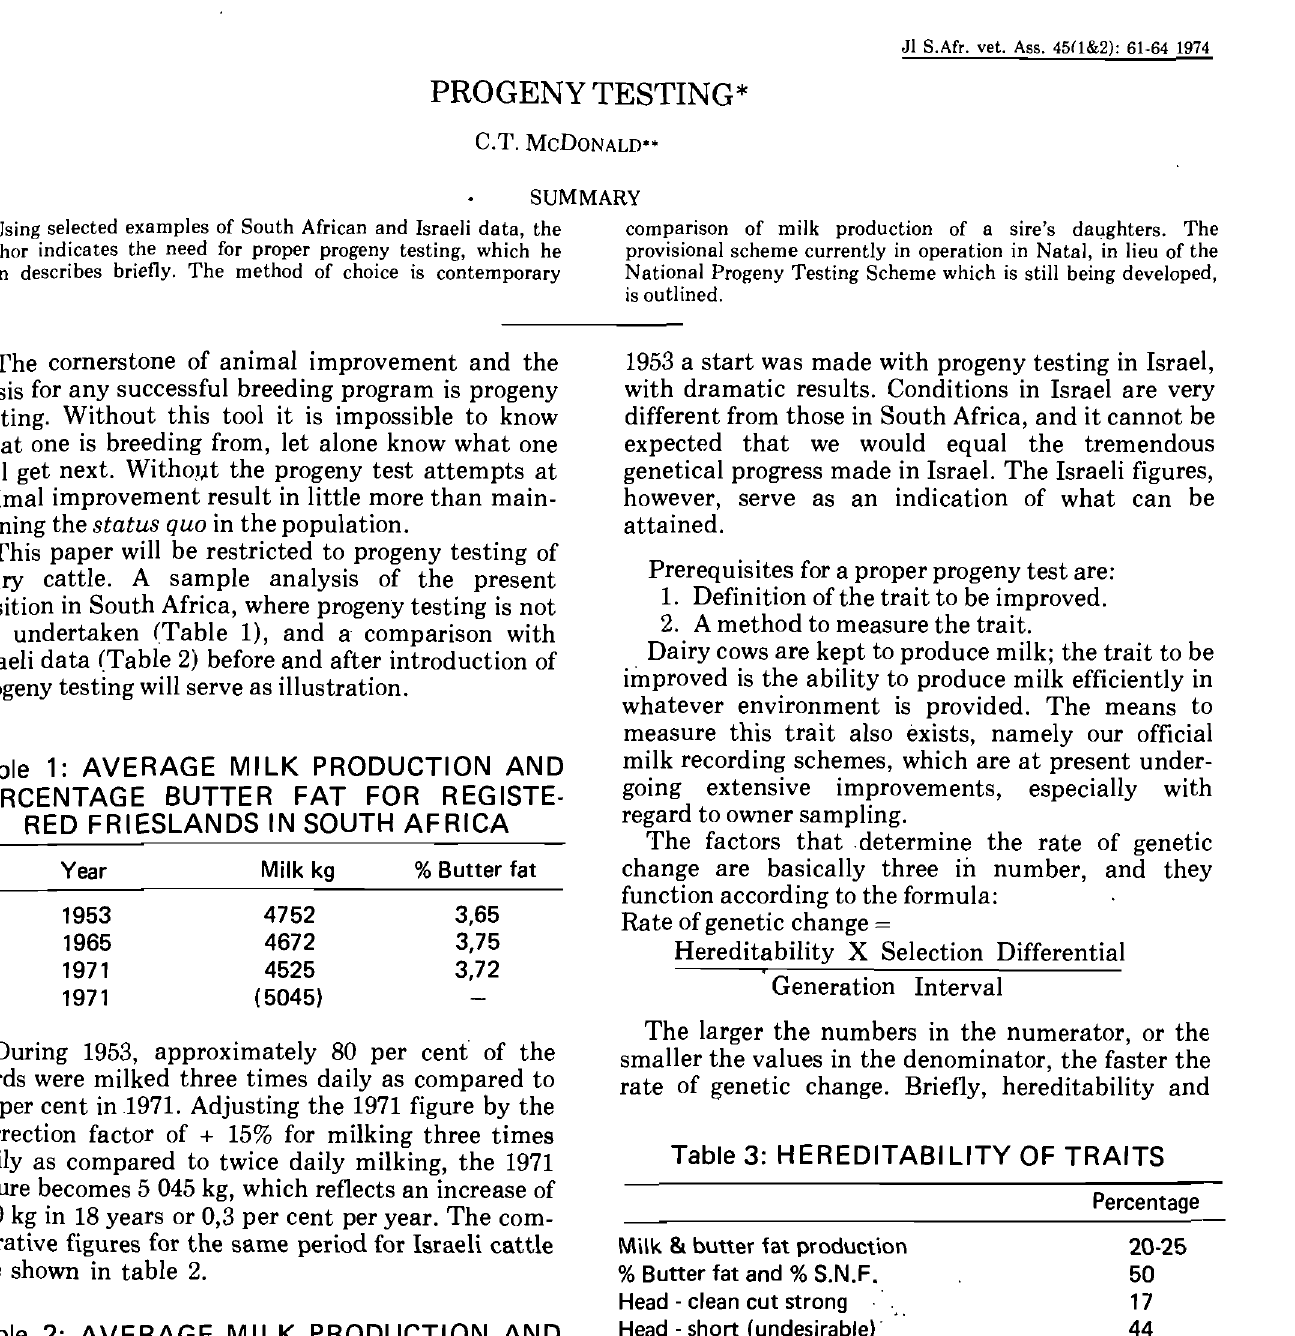
Milk & butter fat production % Butter fat and %